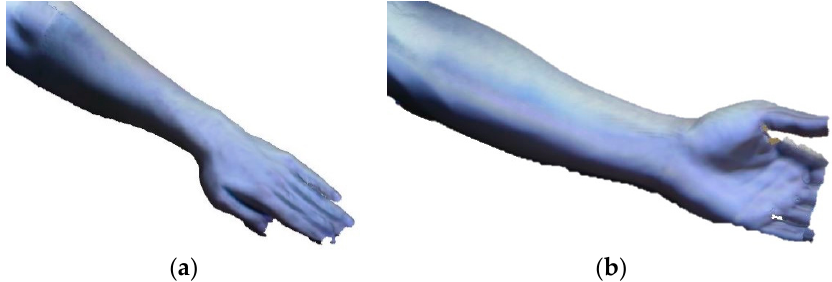
Figure 2. 3D model of the arm obtained after the scanning process: top side ( a ) and bottom side ( b ).